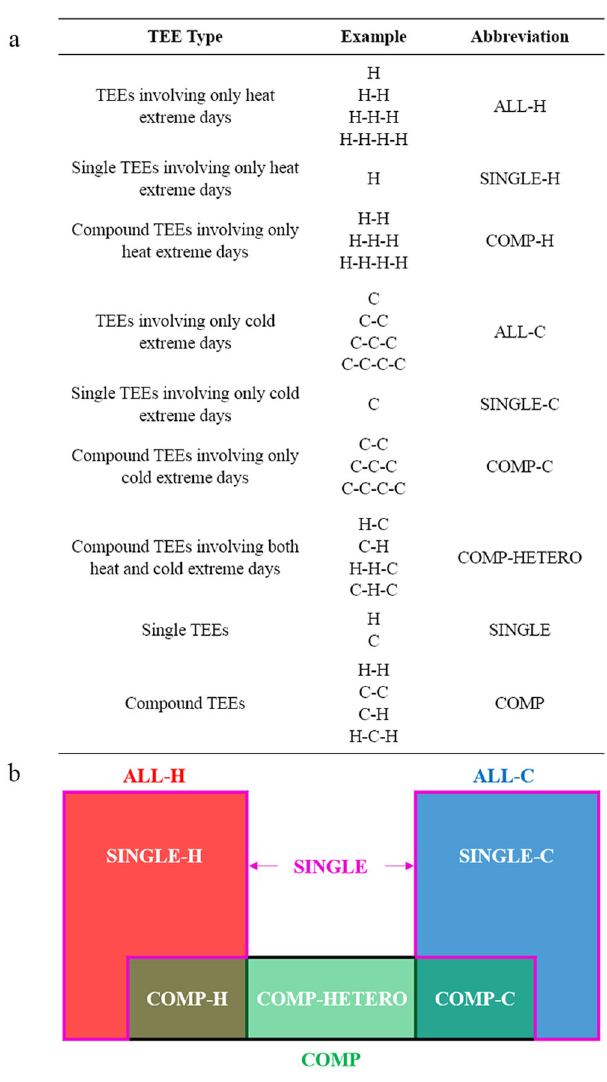
Fig. 2 Major types of temperature extreme events (TEEs). a Examples and abbreviations. b A schematic diagram of relationships among major types of TEEs. Individual TEEs involving only heat and cold extreme days are denoted as H and C respectively. Single and compound TEEs were expressed as H and/or C connected by hyphens (e.g., H represents a single TEE, and H – C represents a compound TEE composed of an H followed by a